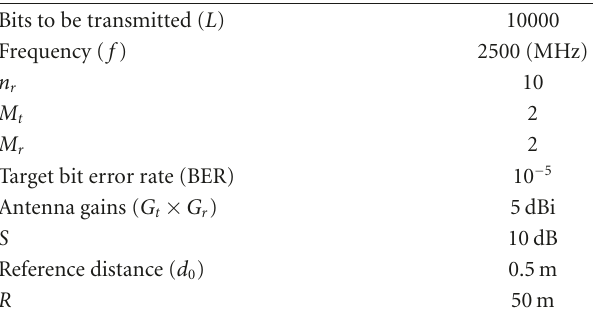
Figure 3: Energy consumption segregation for SISO and MIMO architectures versus distance. Table 2: Indicative parameters value.